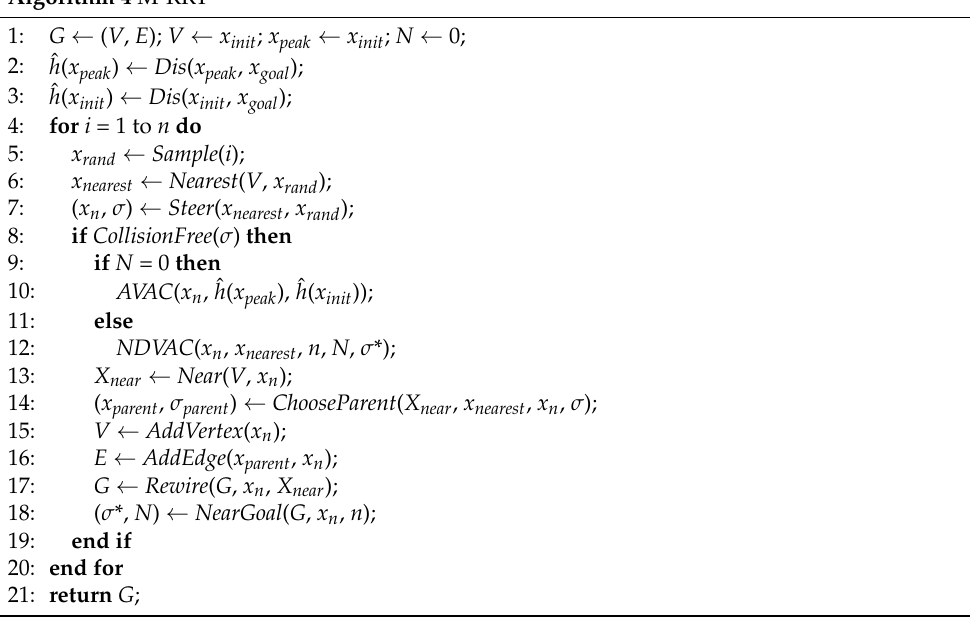
Algorithm 4 M-RRT*